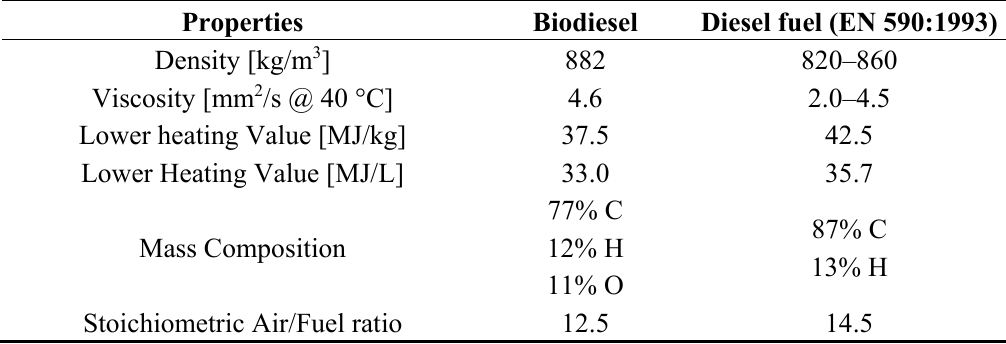
Table 1. Main properties of the rape-seed biodiesel compared to standard diesel